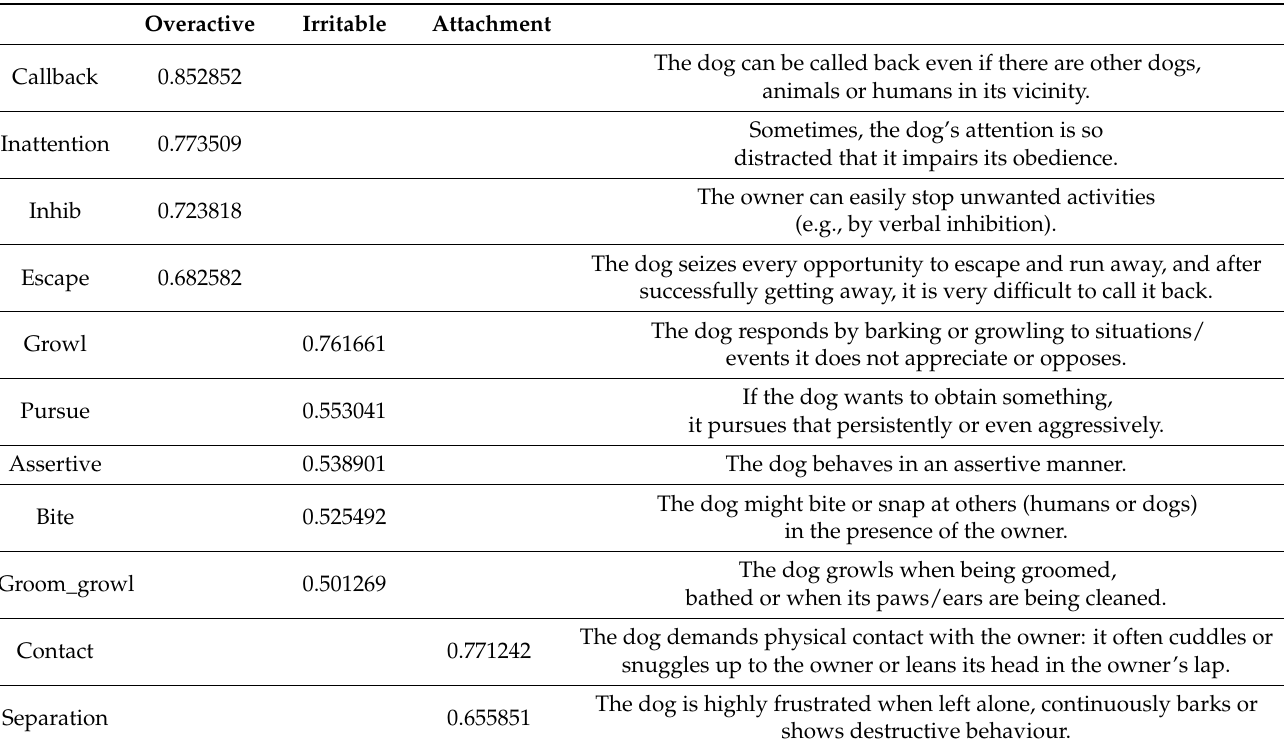
Table 3. The three principal components revealed by PCA on the questionnaire items, and the loadings of each item. Note: principal component “attachment” was eventually excluded from further analysis because of its weak internal consistency. Overactive Irritable